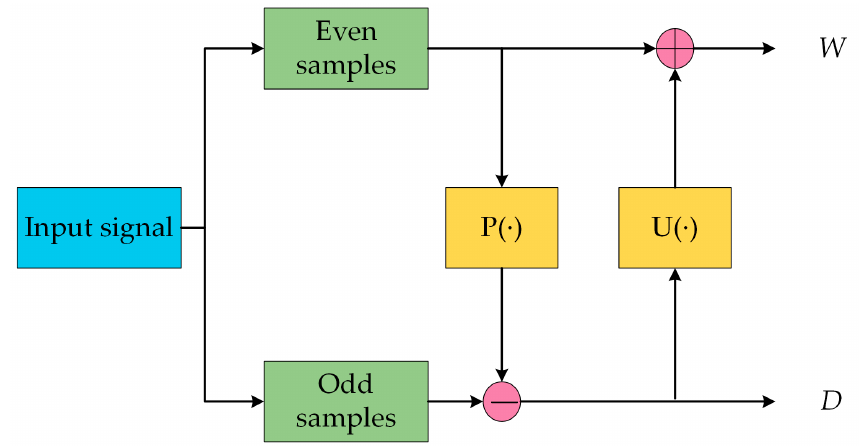
Figure 5. The second ‐ generation wavelet transformation: a sketch map of decomposition.